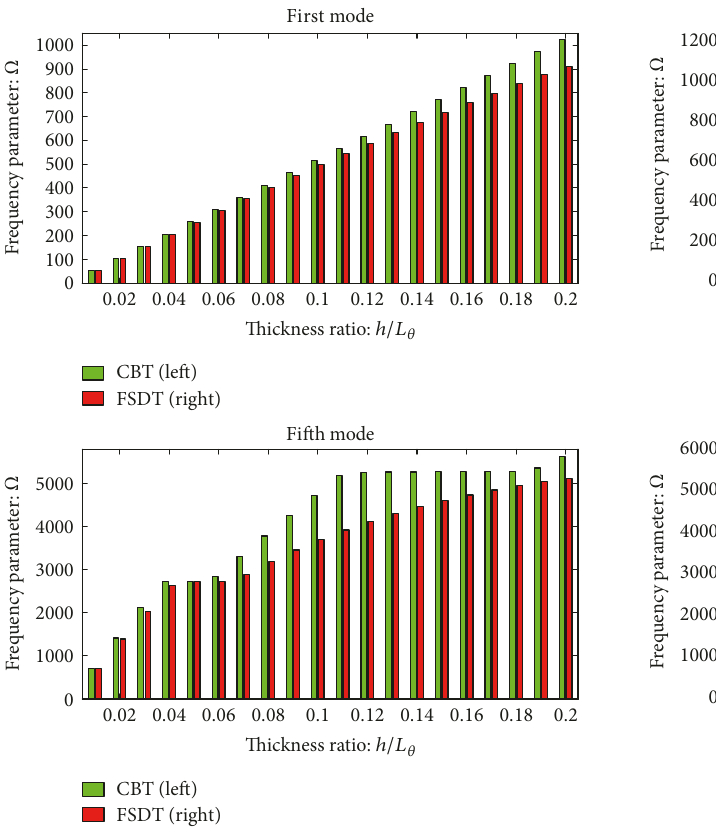
Figure 6: Frequency parameters Ω of circular beams with various thickness ratios based on the CBT and FSDT theory models (F-F boundary condition).